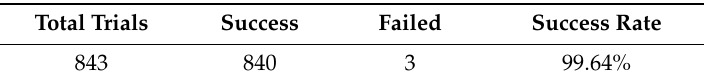
Table 8. Average processing time in each step of the proposed method.